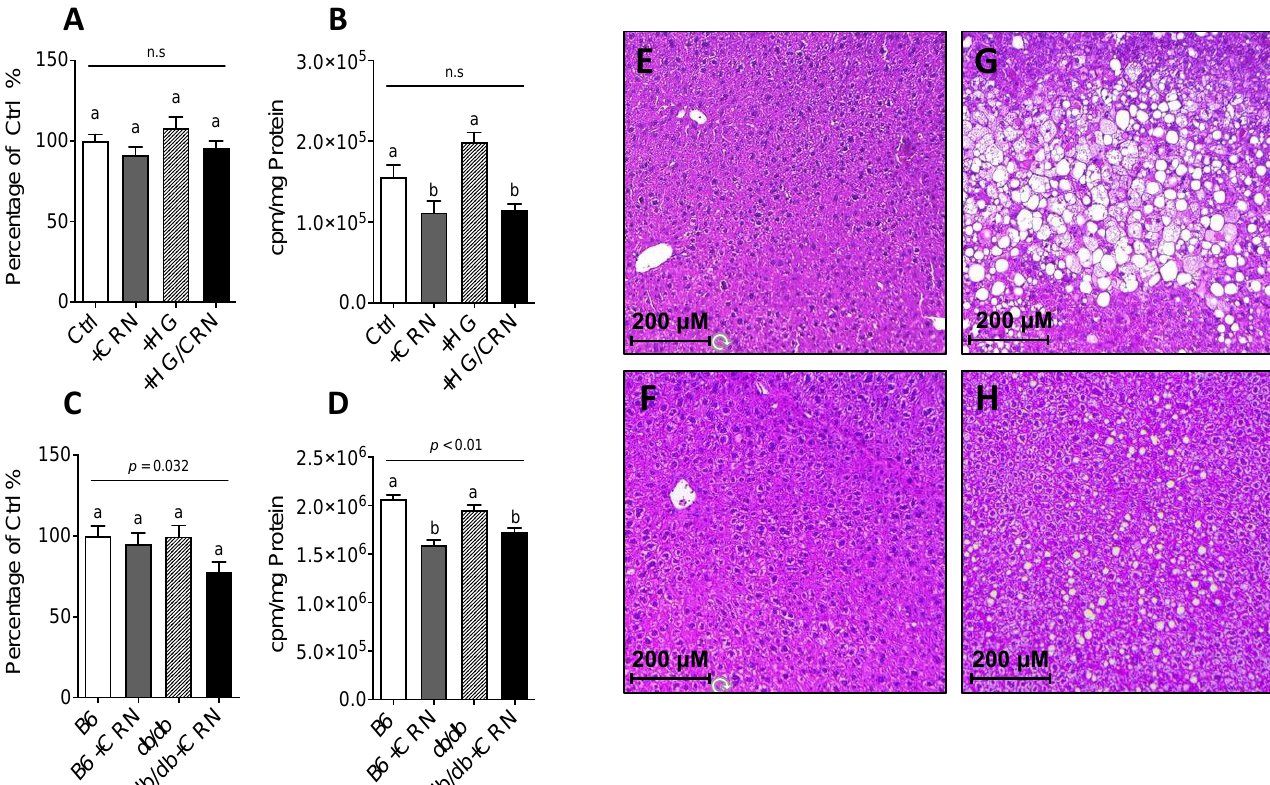
Figure 4. Quantification of total amounts of cholesterol in HepG2 cells with and without 10 mM CRN treatment in 5.5 mM or 30 mM glucose ( A ). Cholesterol biosynthesis in HepG2 cells treated with and without 20 mM CRN in 5.5 mM or 30 mM glucose ( B ). Total cholesterol levels in the livers of control and db/db mice with and without 10 mM CRN treatment ( C ). Radioactive labelled mevalonate incorporation into cholesterol in liver tissue of CRN treated and untreated control (C57B) and db/db mice ( D ). Animal experiments were n = 5 for each condition unless stated otherwise. Values are represented as mean ± SEM. in each group. Statistical analysis was performed using one-way ANOVA with multiple comparison differences denoted. A p -value of <0.05 was considered significant. Liver cryosection histology showing representative microscopy photographs at 10 × depicting steatotic fat droplets with hematoxylin and eosin staining ( E – H ). Sections from each treatment group are shown; upper left panel, untreated control ( E ), lower left panel control + CRN ( F ), upper right panel, untreated db/db ( G ), and lower right panel db/db + CRN ( H ). CRN treatment reduced droplet size and quantity in db/db mice, thereby alleviating pathological signs of hepatic steatosis. Animal experiments were n = 5 for each condition unless stated otherwise. The results shown are the mean of three different experiments performed with five animals in each group. Values are represented as mean ± SEM in each group. (a,b) Different letters indicate significant differences in mean values from repeated-measures ANOVA ( p <